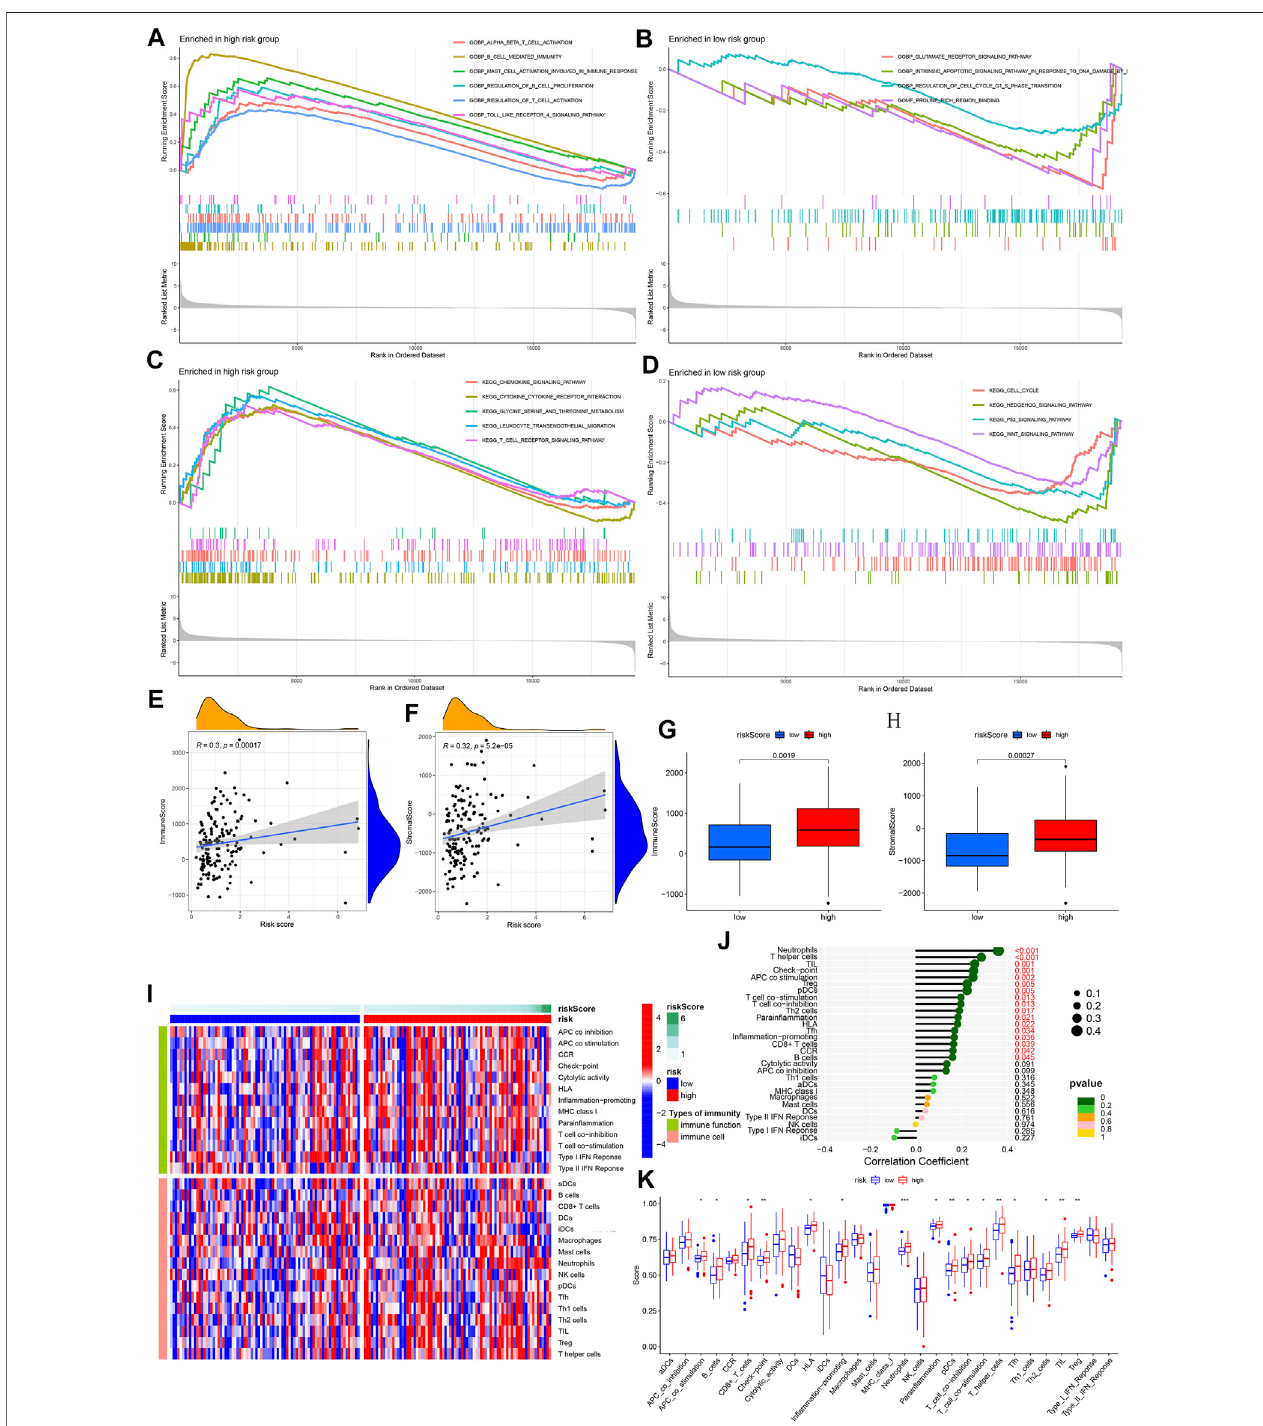
FIGURE 6 | GSEA enrichment and immune in fi ltration assessment analyses. (A – B) GO enrichment analysis for high- and low-risk groups. Based on biological features. (C – D) GO enrichment analysis for high- and low-risk groups. Based on KEGG pathways. Color represents a pre-de fi ned biological function or pathway. (E – F) Correlationanalysisbetweenriskscoreandimmune/stromalcellscore. (G – H) Comparisonbetweenimmune/stromalcellscoreandhigh-/low-riskgroup. (I) Anoverview heatmap of thedifferentscoresof16 immune cellsand 13immunefunctions as therisk scoreincreases. (J) The correlation between 16types ofimmunecells, 13 types of immune function, and risk score. (K) Analysis of the difference between 16 types of immune cells, 13 types of immune function, and high-/low-risk groups.